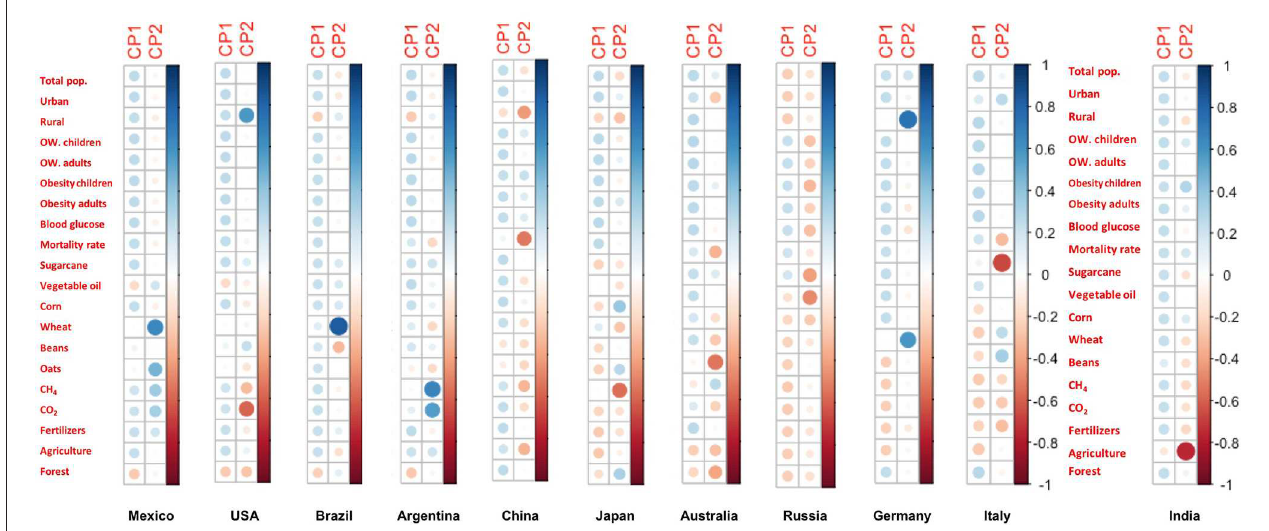
FIGURE 4 | Multiple correlation analysis of health, environmental, and agricultural production variables for each country. The colorimetric scale represents a positive (Blue) or negative (Red) association between the main components. Simultaneously the circle dimension represents the level of this association.